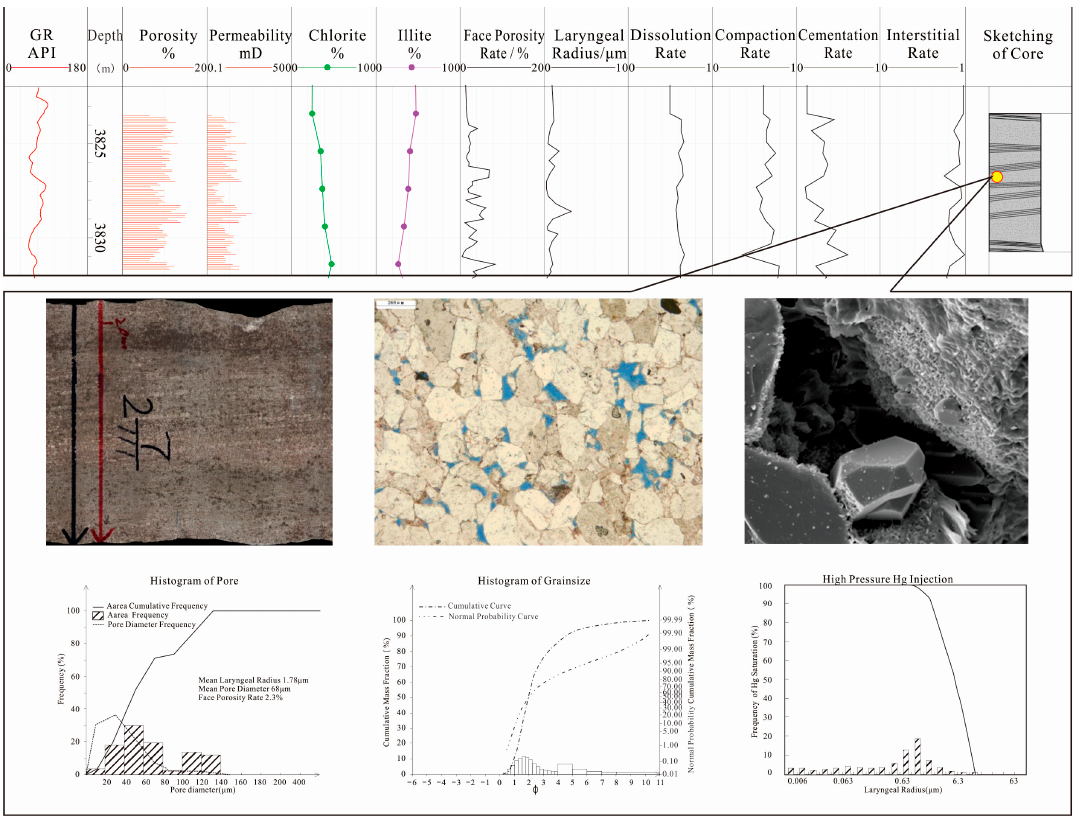
Figure 14. Section and petrographic photographs of type I chlorite sedimentary facies in H3 of well X-2.